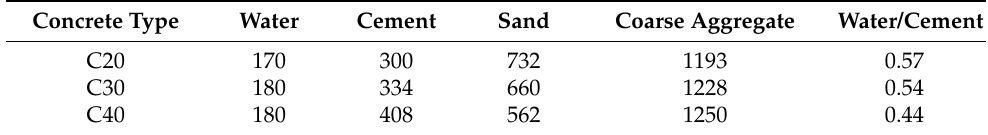
Table 3. Mix proportions of concrete (kg/m 3 ).